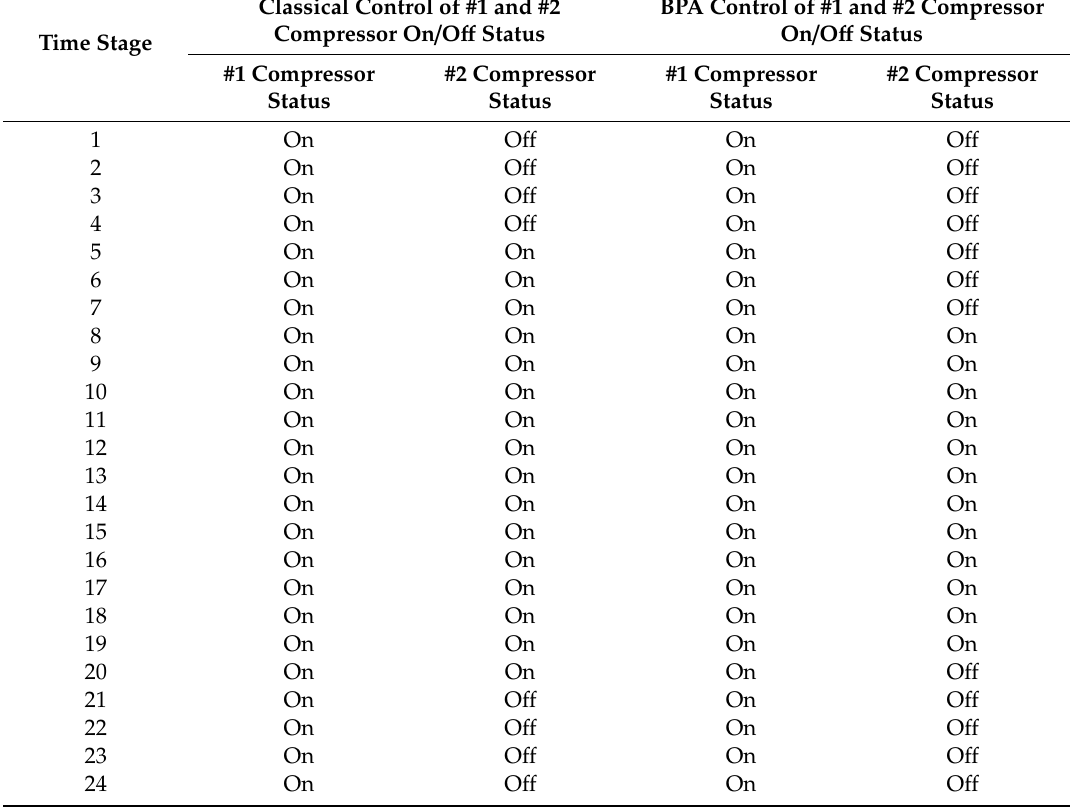
Table 3. Compressor on / o ff status under classical control of refrigerating chamber. BPAbinary proteome algorithm.